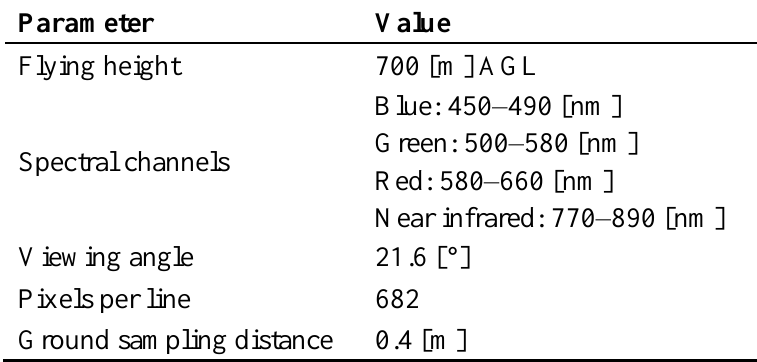
Table 1. Flight and technical parameters of the flight campaign in summer 2008 using a multispectral line scanner integrated in the ―Falcon II system‖ (AGL = above ground